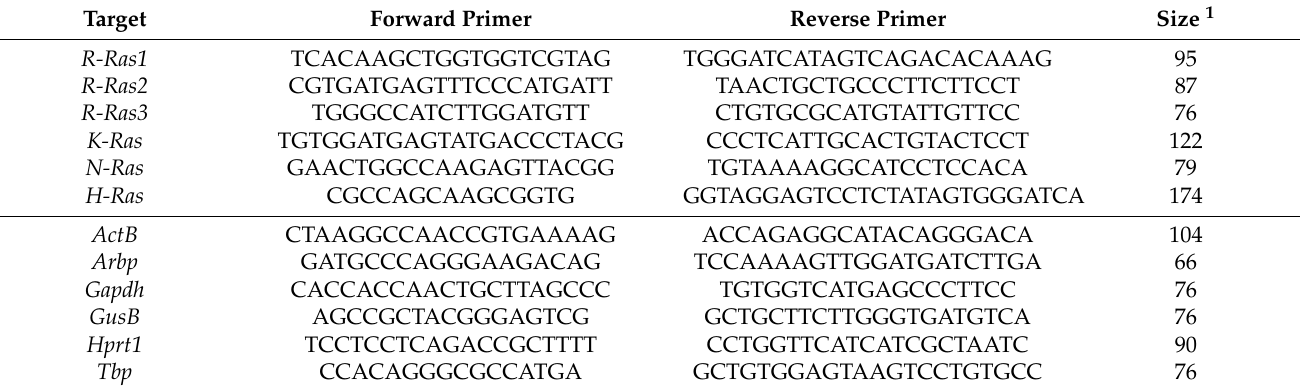
Table 2. Primer sequences used for RT-qPCR. Primer sequences are stated from 5 (cid:48) to 3 (cid:48)